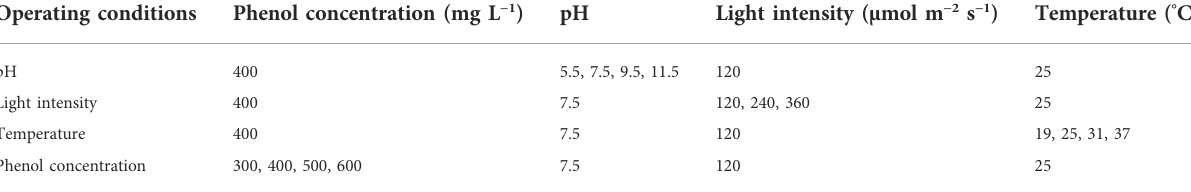
TABLE 1 The culture parameters of different operating